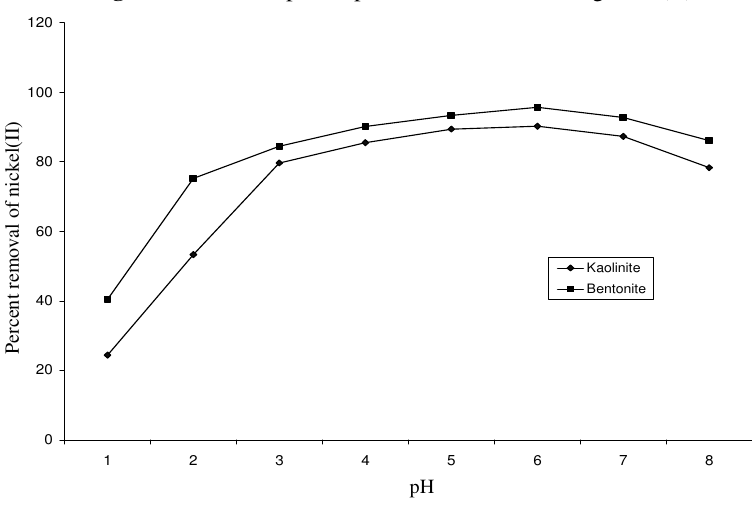
Figure 1. Effect of pH on percent removal of manganese(II)